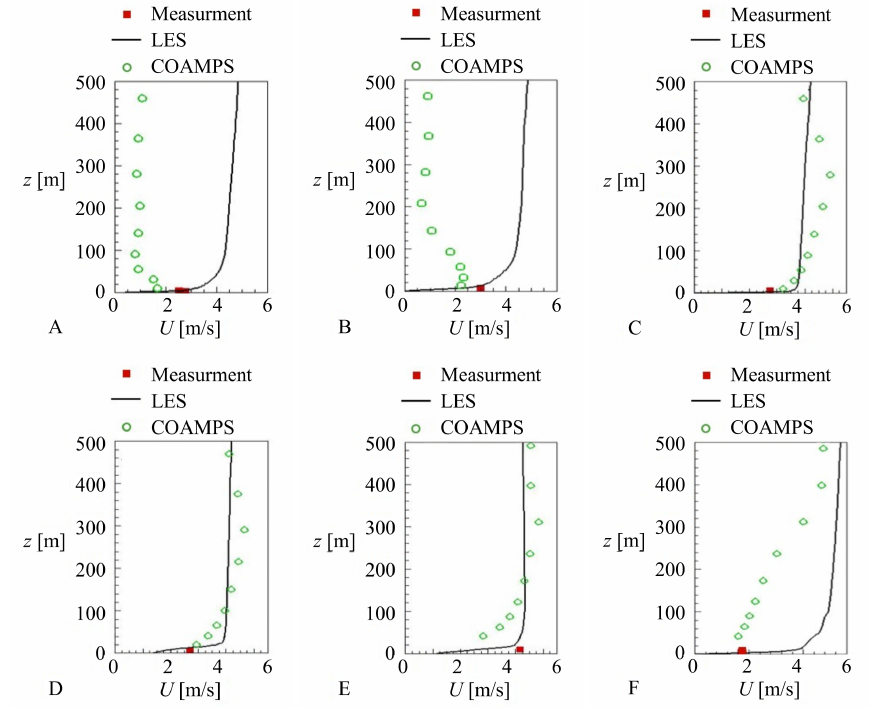
Figure 3. Profiles of mean streamwise velocity U at locations ( A ), and ( B ) in case ESB1, ( C – E ) in case MAB (Marina Beach), and ( F ) in case DMB (Del Monte Beach). See Figure 1 for locations A–F.